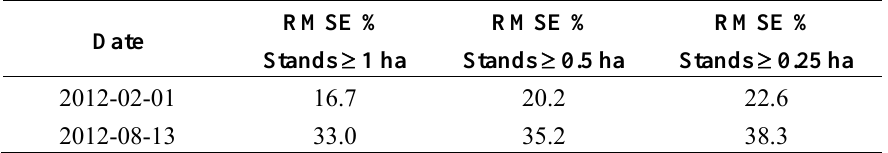
Table 5. Relative RMSE in the case of the IWCM as a function of minimum forest stand size. The two acquisitions with the smallest and largest RMSE are shown for